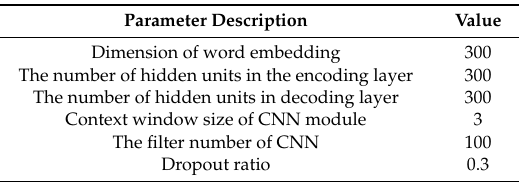
Table 15. Hyper parameters of the hybrid neural network.